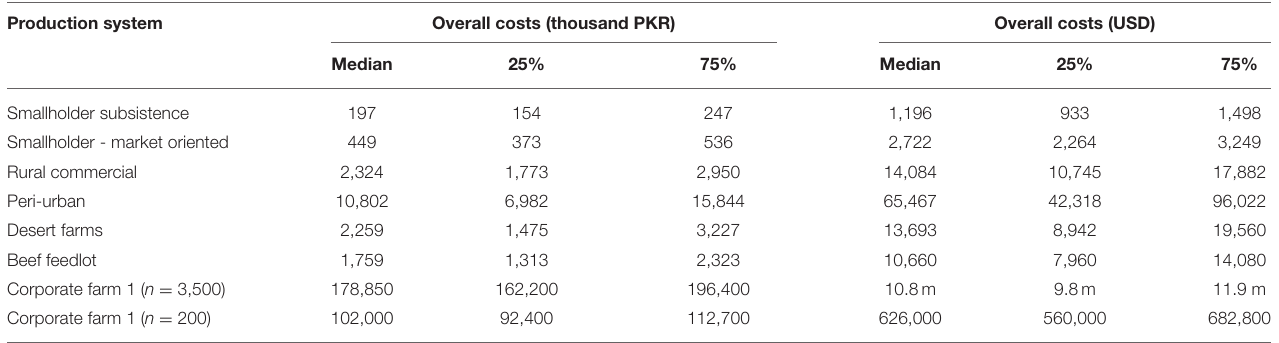
TABLE 5 | Model outputs for production systems showing discounted costs for a foot-and-mouth disease (FMD) outbreak at the farm level (median and 25th/75th percentiles). Production system